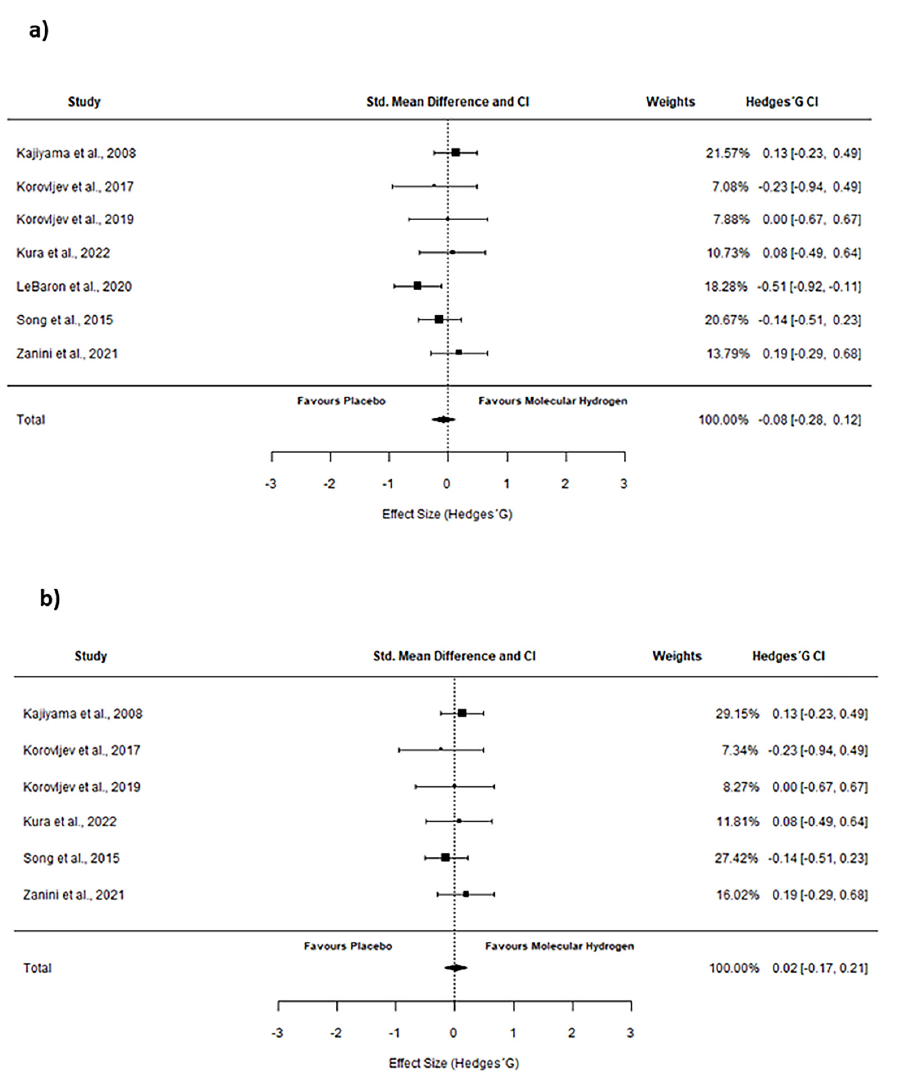
Figure 5. Forest plots of included studies considering High-density lipoproteins. Forest plot com- paring the effects of HRW supplementation on HDL. ( a ) represent results from all of the studies included in this SRMA. ( b ) represent the results after excluding one study not evenly distributed around the base of the funnel plot. The results for all studies showed a trivial negative effect (pooled SMD = − 0.08 [from − 0.28 to 0.12], p = 0.23); Following the exclusion of not evenly distributed study,